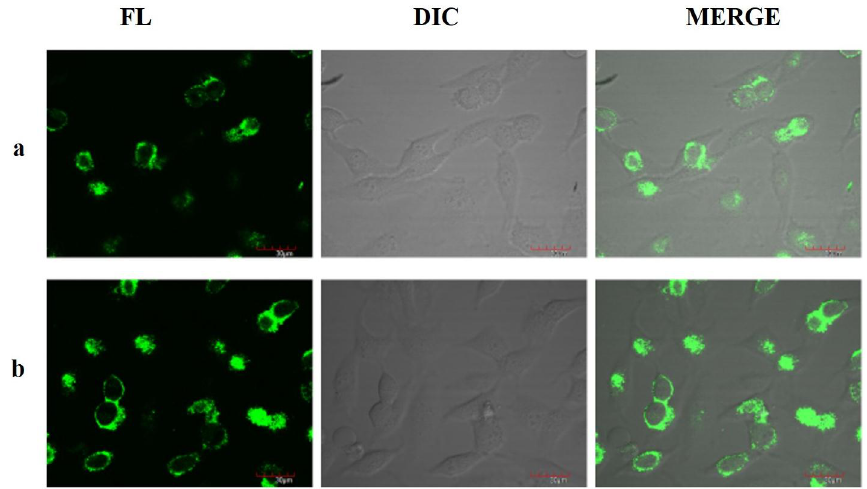
Figure 3. TP confocal images of HeLa cells ( a ) with compound 7 and ( b ) compound 8 . FL: coumarin fluorescence images; DIC: (differential interference contrast images); and MERGE: Fluorescence images merged with DIC.